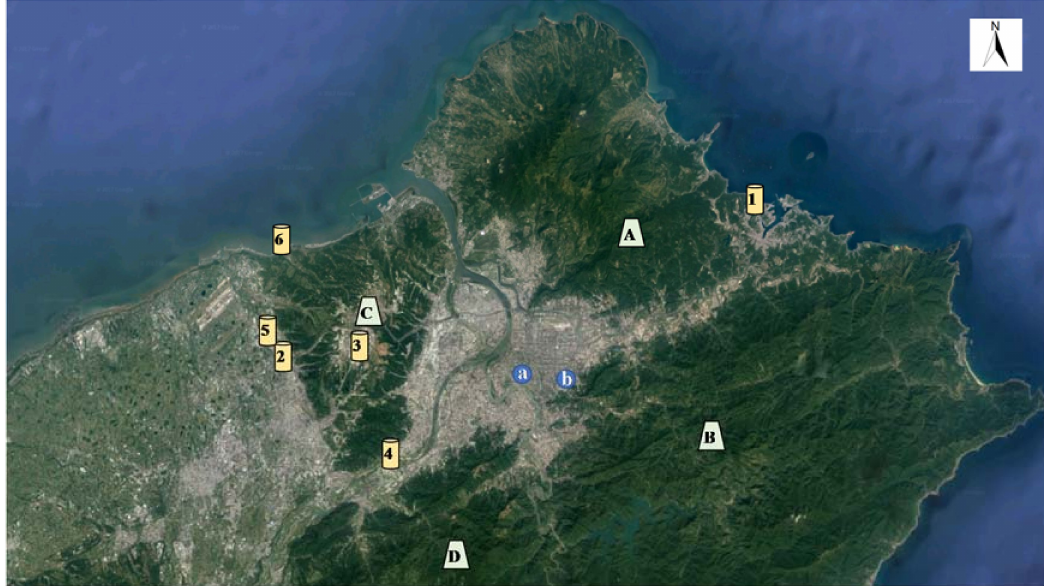
Figure 1. Environment surrounding the monitoring site: a indicates the Chungcheng Air Quality Monitoring Station, where online monitoring was also conducted, and b represents the vertical observation site at the Taipei 101 building. A shows the Tatung mountain group, B indicates the Songshan hills, C is the Linkou plateau, D indicates the Xueshan range, and 1–6 show the top six emission sources with the highest effects on the air quality in northern